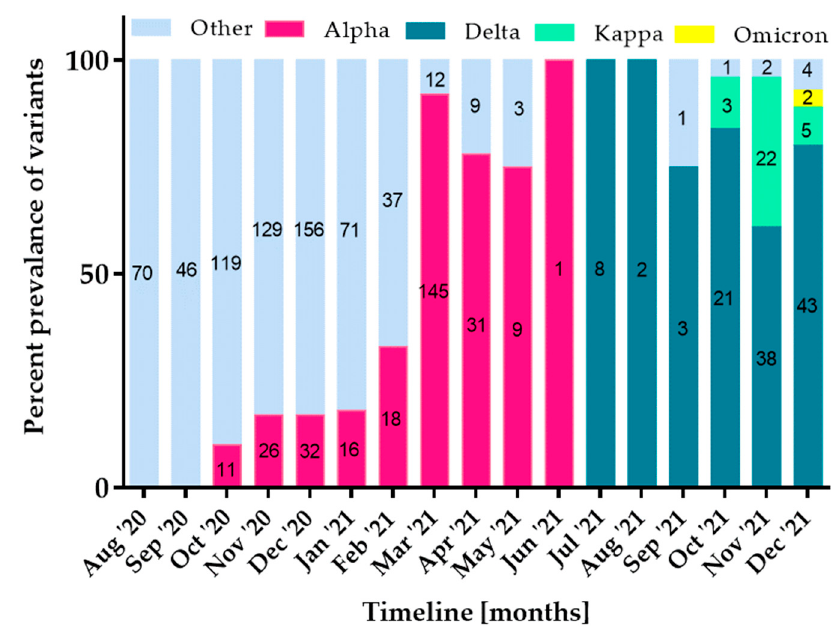
Figure 1. The timeline of distribution of SARS-CoV-2 variants. The light blue color represents specimens for which the tested mutations were not identified, red corresponds to Alpha, dark blue—Delta, green—Kappa, yellow—Omicron variant. The values in the columns indicate the number of samples. Table 4. The monthly prevalence of SARS-CoV-2 variants in particular centers.